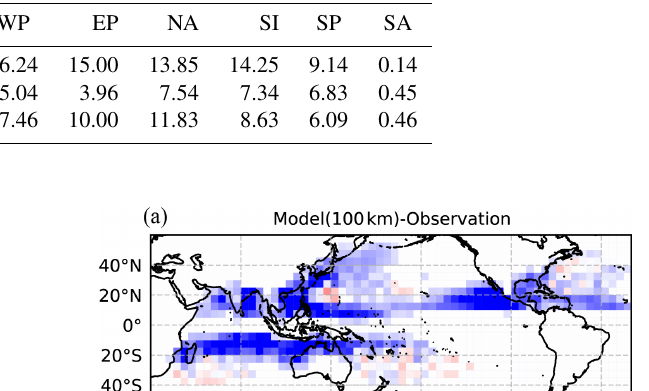
Table 4. Observed and simulated average tropical cyclone number, both globally and by ocean basin, in the northern Indian (NI), western Pacific (WP), eastern Pacific (EP), northern Atlantic (NA), southern Indian Ocean (SI), southern Pacific (SP) and southern Atlantic (SA) oceans.